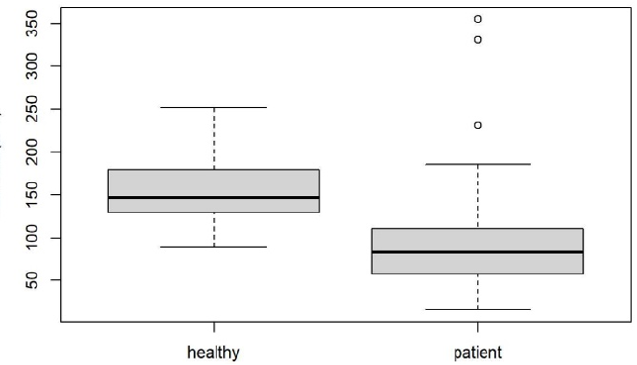
Figure 7. Box blot diagram showing Stiffness in healthy volunteers compared to patients.